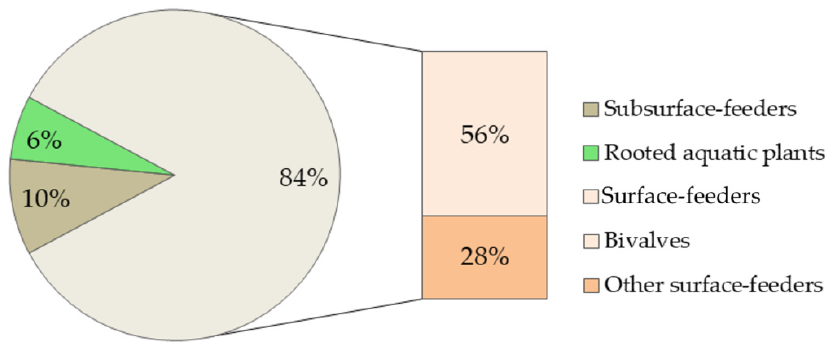
Figure 4. The number of studies including different benthic organism groups based on the data from bibliometric search (Table 1) for macrophytes and benthos (reviews omitted). Altogether 32 species from 23 papers (21 papers on benthos and two papers on macrophytes). Subsurface-feeders included oligochaetes and amphipods Corophium volutator . “Other surface-feeders” were collector-feeders (insect larvae, crustaceans, snails) and predators (insect larvae, mites).